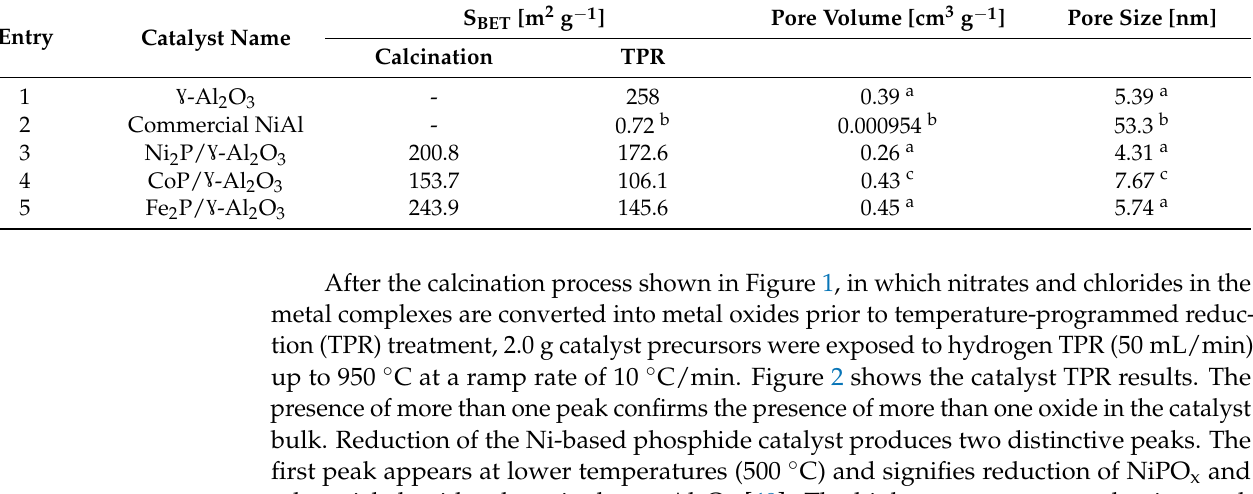
Figure 2. H 2 -TPR profiles of 5 wt.% (a) Ni 2 P/ ɣ -Al 2 O 3 , (b) CoP/ ɣ -Al 2 O 3 , and (c) Fe 2 P/ ɣ -Al 2 O 3 supported